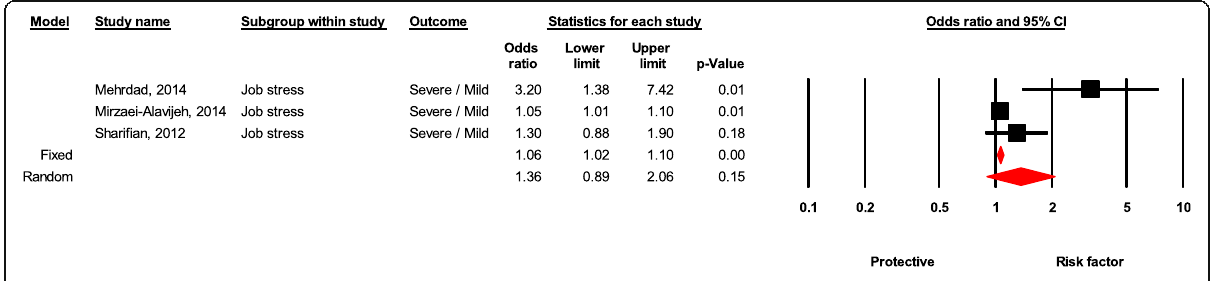
Fig. 6 Forest plot for relationship between job stress and risk of NSI in Iran